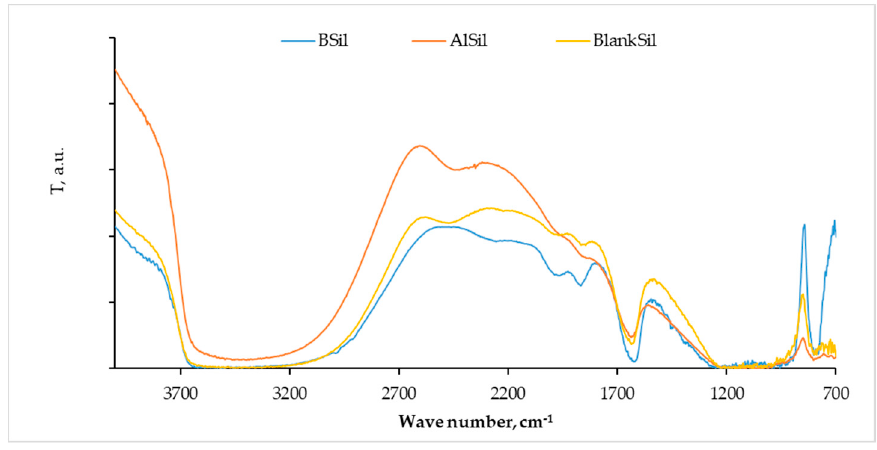
Figure 1. Fourier transform infrared (FTIR) spectra of the blank matrix and matrices with the immobilized catalysts BF 3 and AlCl 3 . BSil—blue, AlSil—orange, BlankSil—yellow.